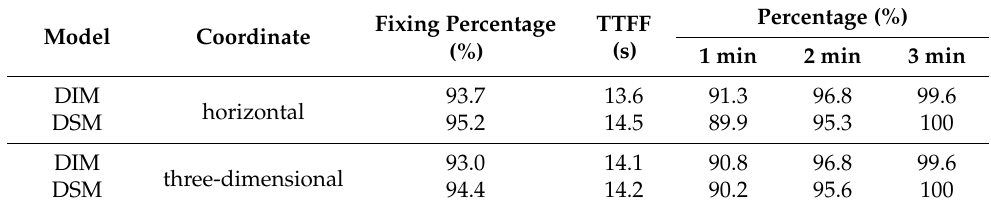
Table 3. Statistics of PPP-RTK simulating dynamic convergence results in the medium-scale networks.